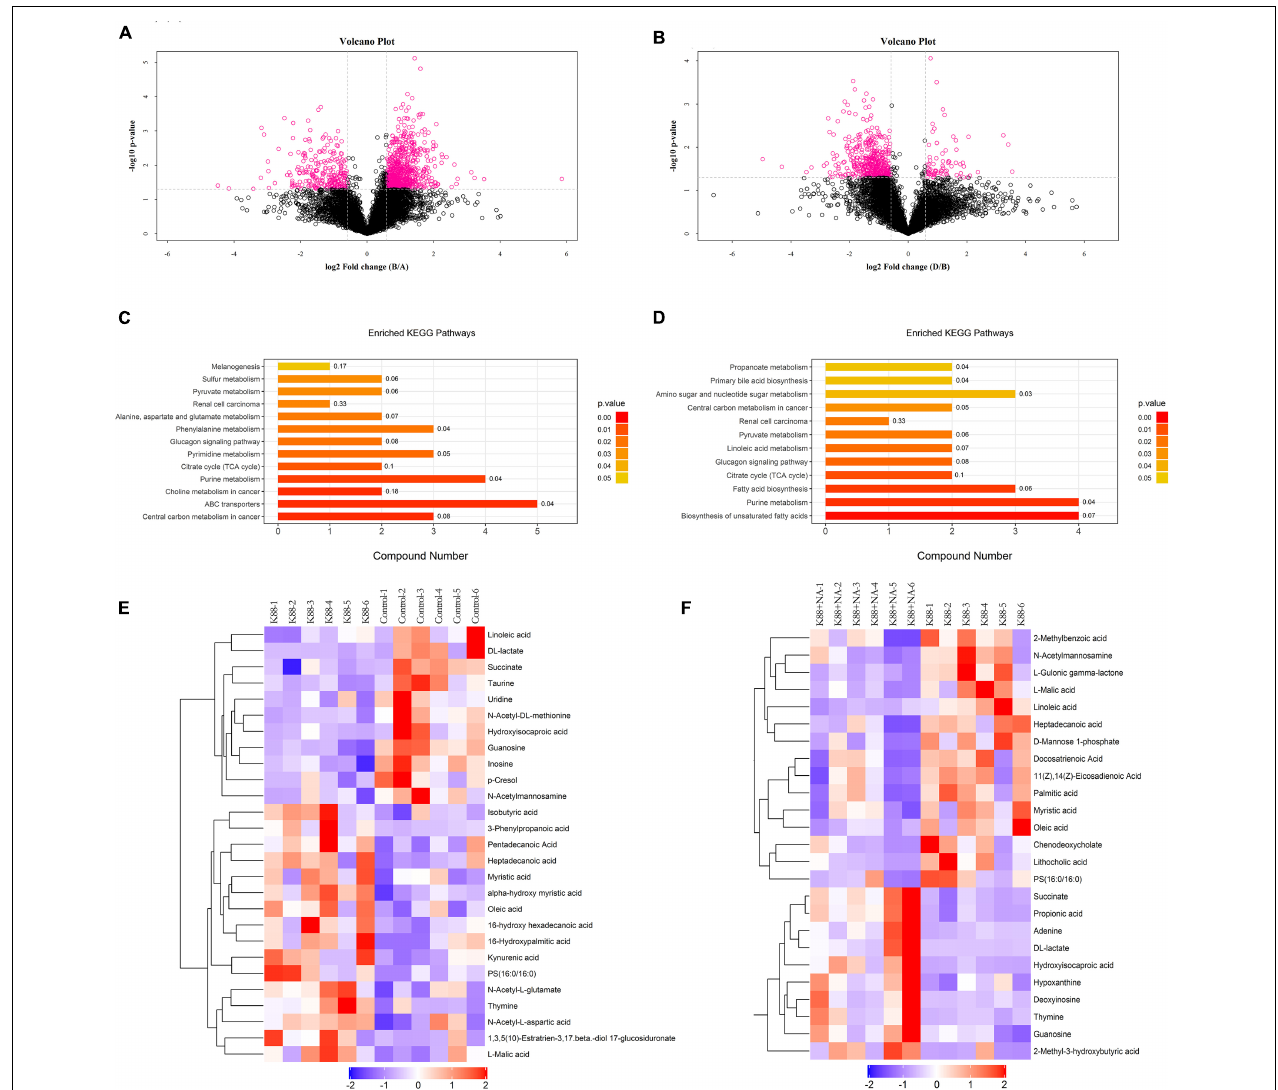
FIGURE 6 | Metabolomic analysis of the colonic contents in weaned pigs caused by E. coli infection. Volcano plot in HILIC negative between K88 and Control (A) and negative between K88 + NA and K88 (B) ; Enriched KEGG pathways analysis between K88 and Control (C) , between K88 + NA and K88 (D) ; Hierarchical clustering of the differentiated metabolites in HILIC negative between K88 and Control (E) , between K88 + NA and K88 (F)